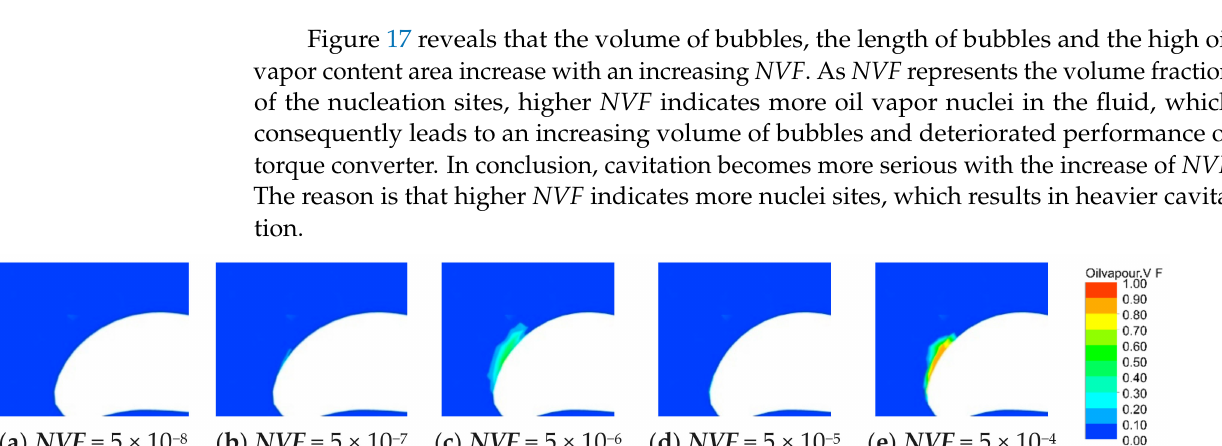
Figure 16. Oil vapor volume fraction distribution on stator blades at stall under various nuclei volume fractions.